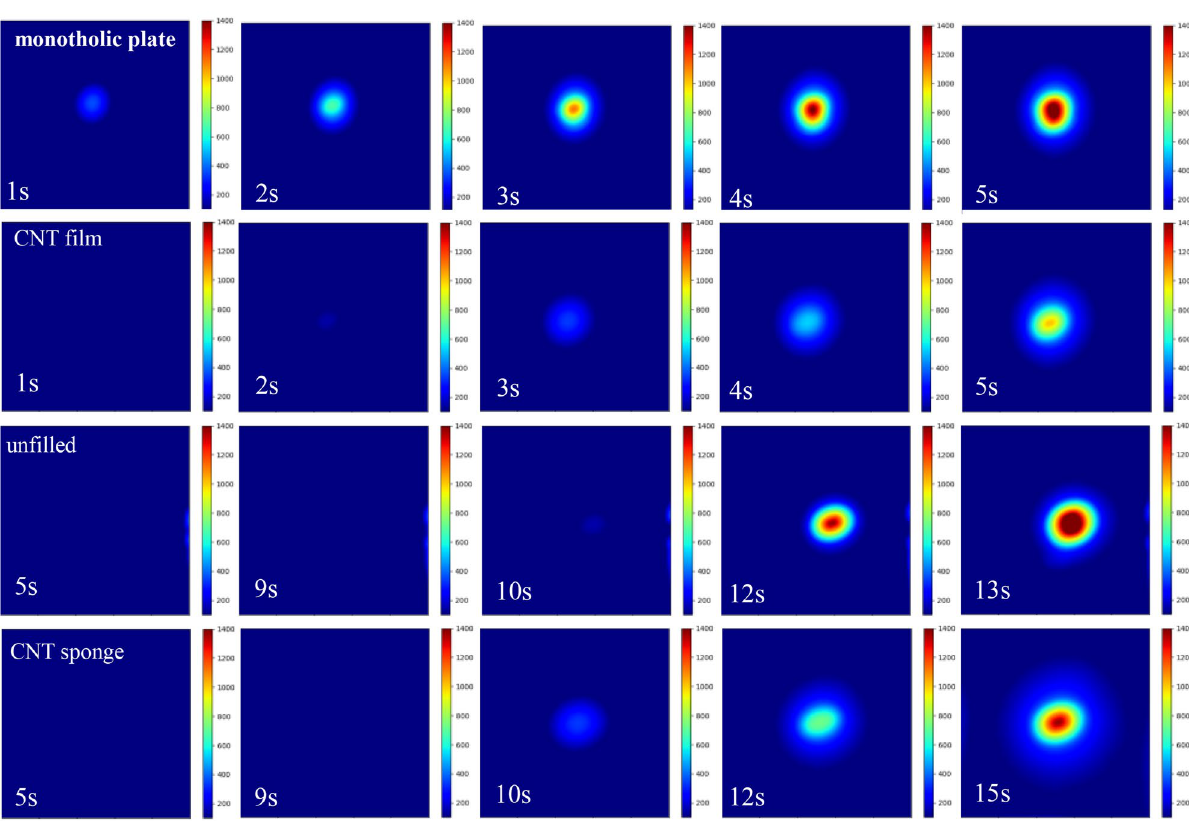
Figure 4. Temperature distribution in the back surface for monolithic plate, CNT film filled sandwich panel, unfilled sandwich panel and CNT sponge filled sandwich panel at different irradiation time, obtained by the thermal imaging